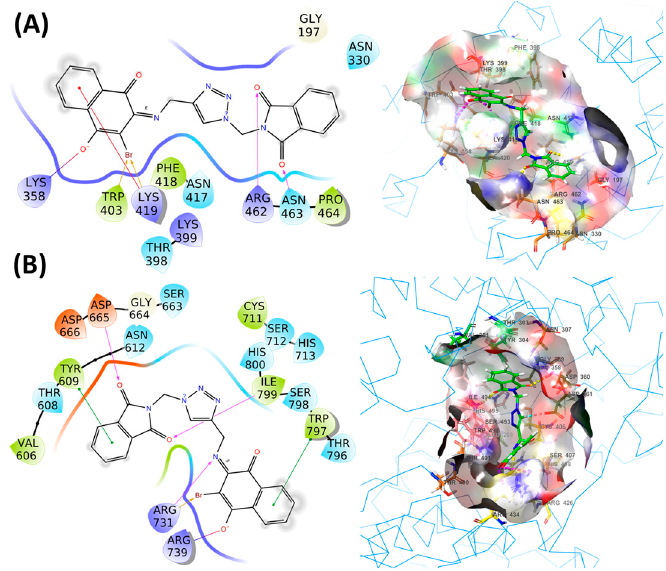
Figure 7. 2D-3D diagram of ligand-protein complex. ( A ) 4b -helicase (6MH3) complex. ( B ) 4b -RdRp (5U04) complex.